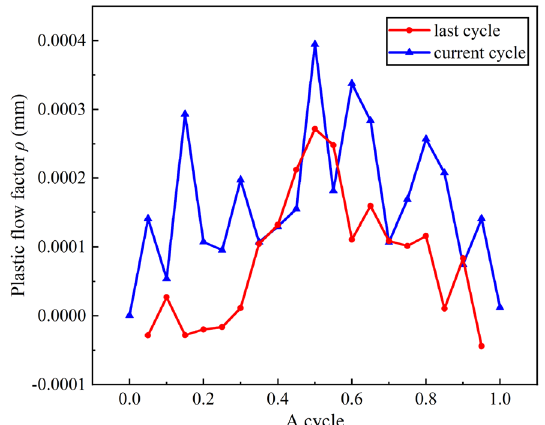
Figure 11 Variation trend of stress intensity factors K CJP and K CJP * with load